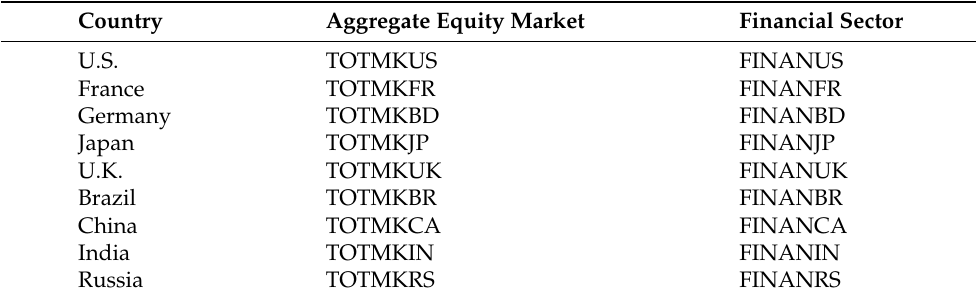
Table 1. Ticker of the equity indices in Datastream. Country Aggregate Equity